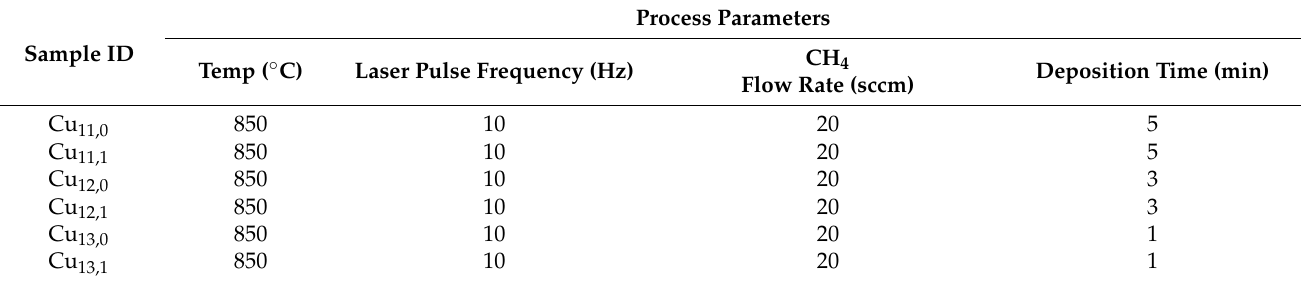
Table 1. Experimental parameters of different deposition times with constant CH 4 flow rate at 20 sccm and 850 °C deposition temperature.